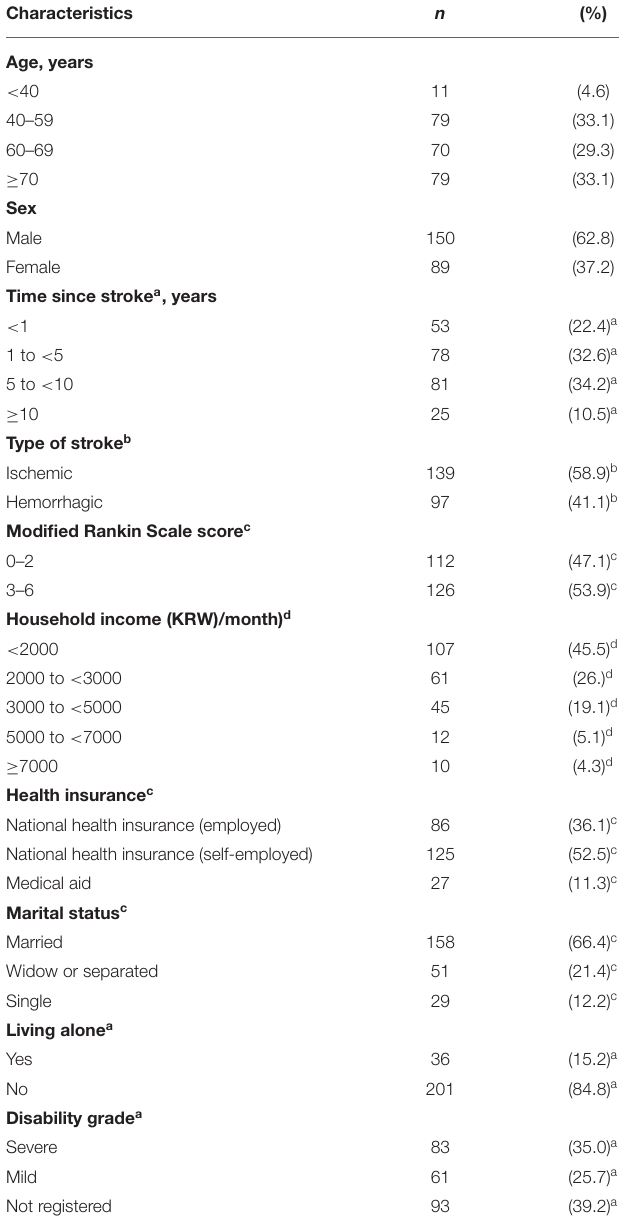
TABLE 1 | Baseline patient characteristics ( n =